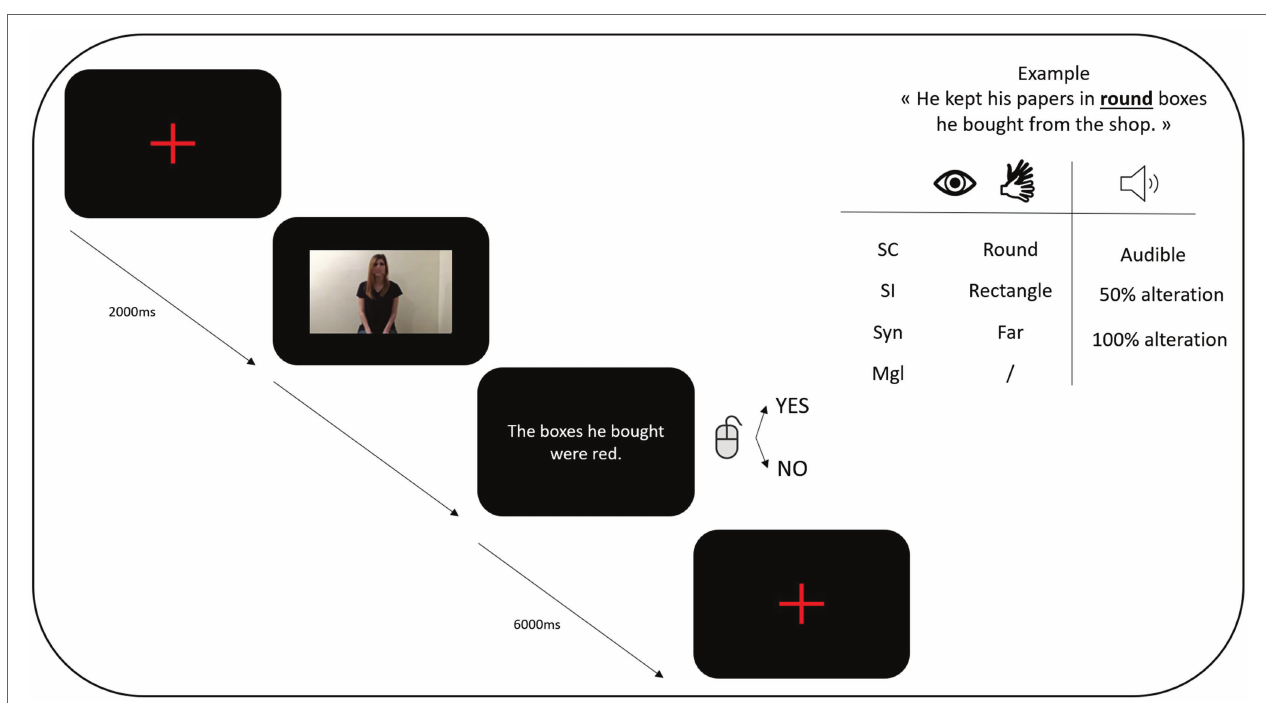
FIGURE 1 | Representation of the proceeding of a task (Sc = semantically congruent; SI = semantically incongruent; Syn = syntactically incongruent; Mgl =